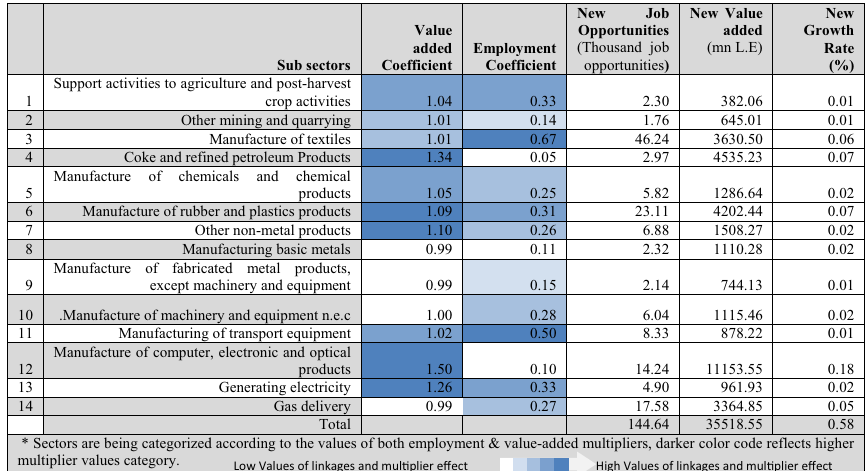
Figure 6. Effects of the FSP on both growth and employment of